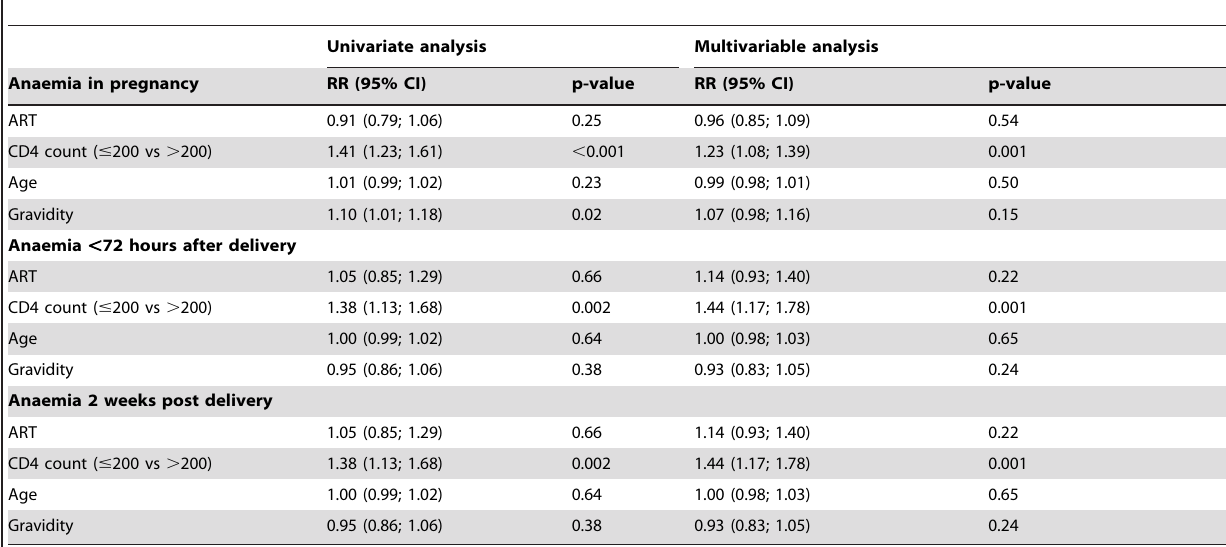
Table 4. Association between HIV Disease Stage and Anaemia in Pregnancy and